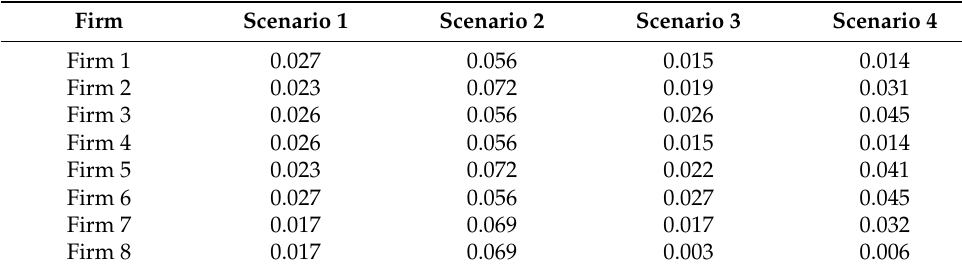
Figure 9. Comparison of consumer areas of all scenarios. Table 4. Profits of the Nash